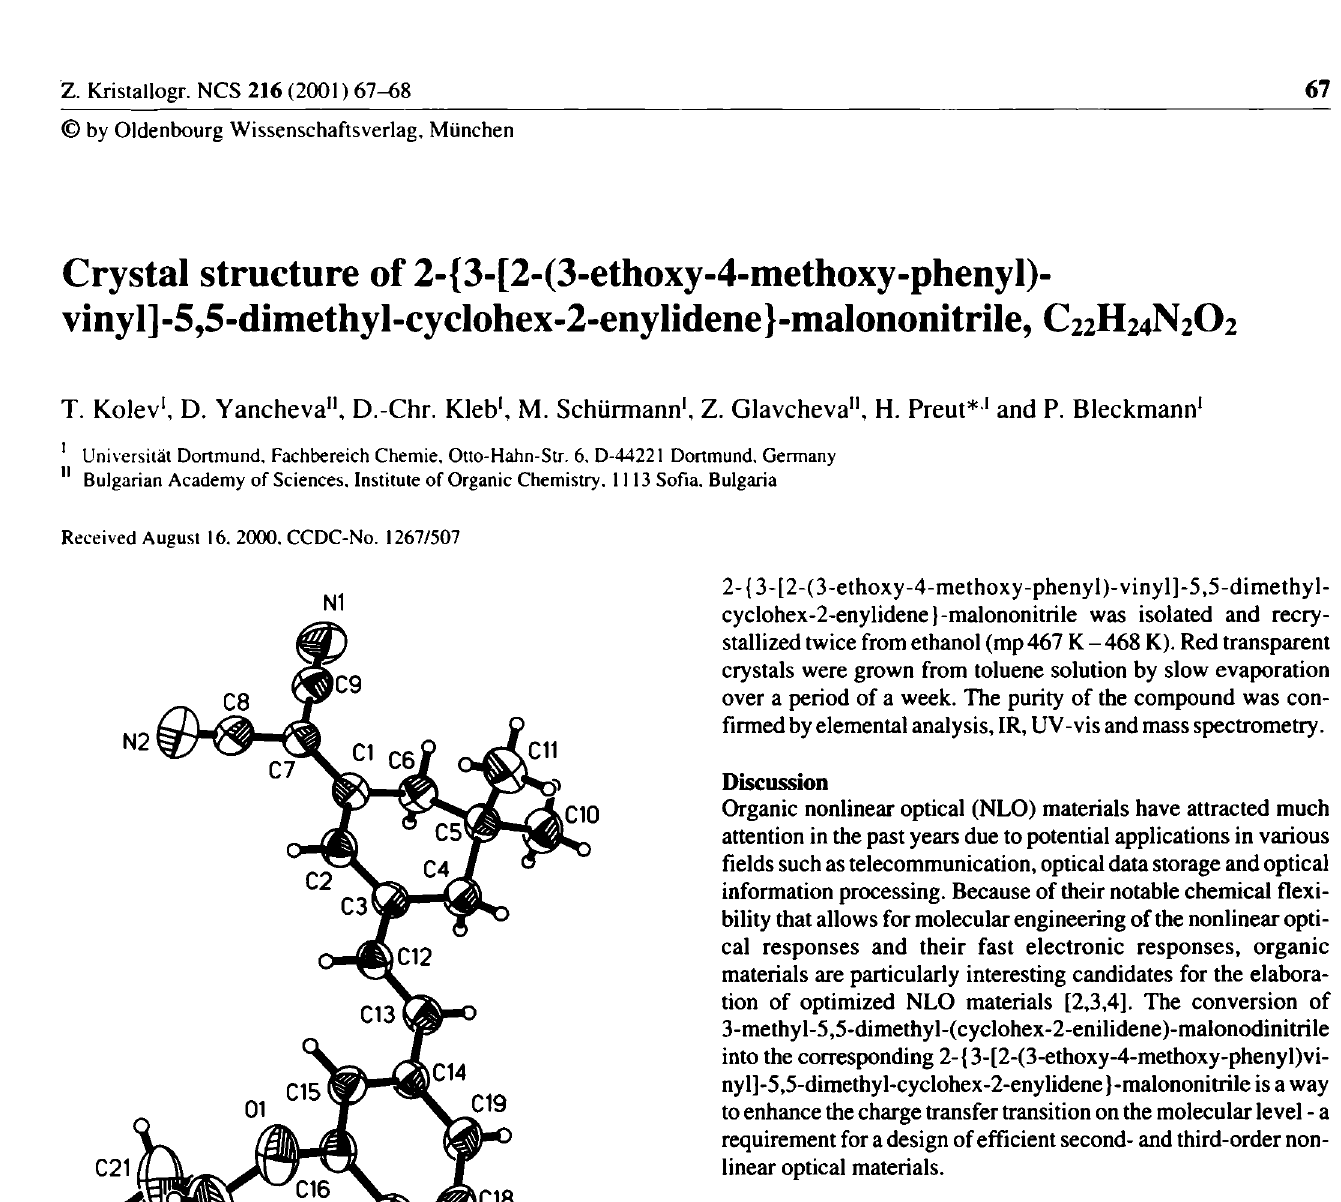
Table 1. Data collection and handling.